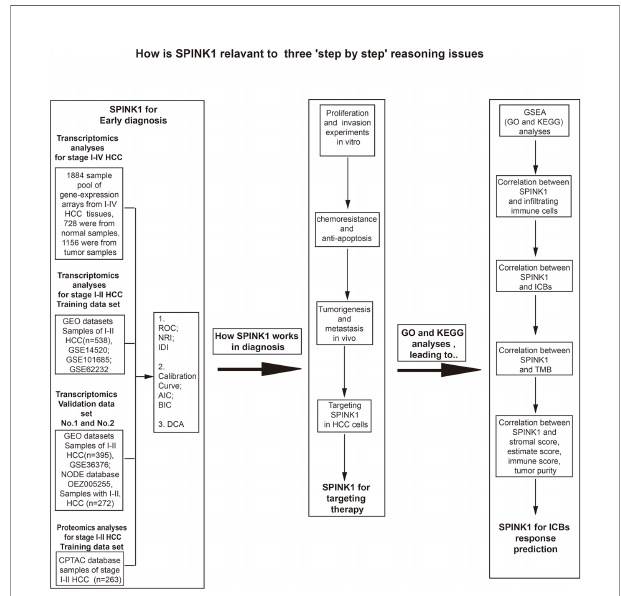
FIGURE 1 | Flowchart of the three goals of this investigation: step-by-step bioinformatics analyses, bench-side experimental design, and eligibility criteria for the collection of tissue samples from patients with hepatocellular carcinoma (HCC) from different